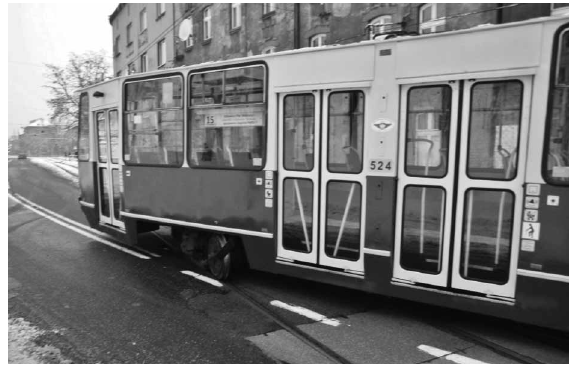
Fig. 8. Tram derailment over a switch